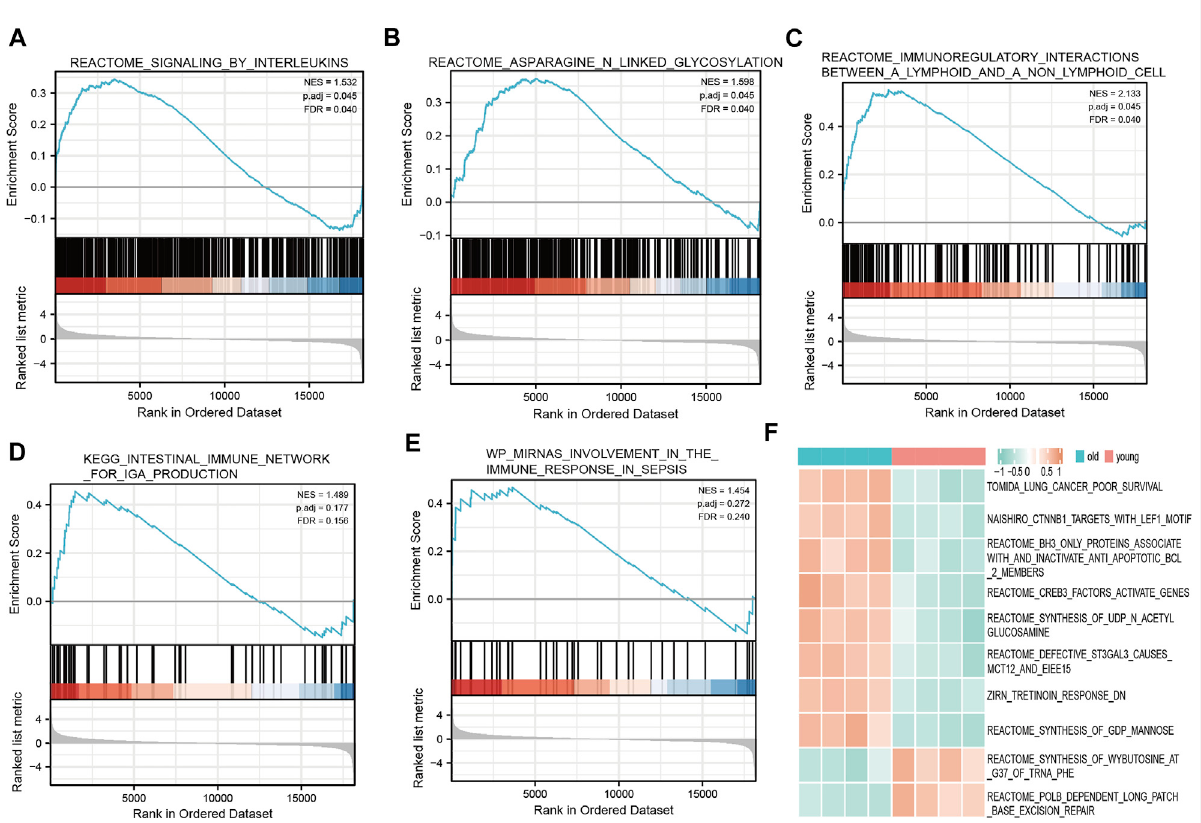
FIGURE 6 GSEA and GSVA. GSEA revealed the following Reactome pathways were enriched in the elderly LFH group: (A) Signaling by interleukins; (B) asparagine linked glycosylation; (C) immunoregulatory interactions between a lymphoid and a non-lymphoid cell. The enriched KEGG pathways were: (D) Intestinal immune network for IgA production; and (E) miRNA involvement in the immune response in sepsis. (F) Results of GSVA. Pink annotation bars indicate theyoung normal LF group, blueannotation barsindicate theelderly LFHgroup. The heatmap shows the GSVAscores for each pathway in this